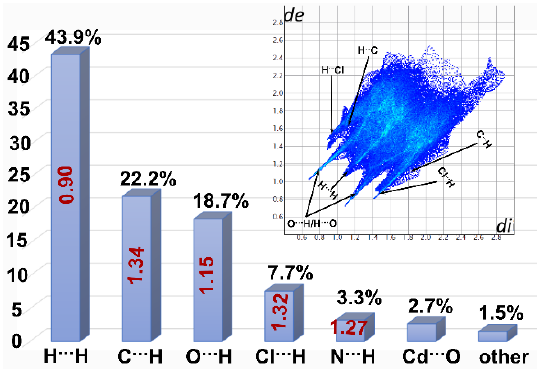
Figure 8. A 2D fingerprint plot (FP) of the title complex with the percentage contributions to the Hirshfeld surface areas for the major intermolecular contacts and their respective enrichment ratio (ER) values-in red; de and di are the distances to the nearest atom exterior and interior to the surface, respectively; ER values were not computed for the actual contacts’ contribution below 2% and random contacts below 1% as they are not meaningful.